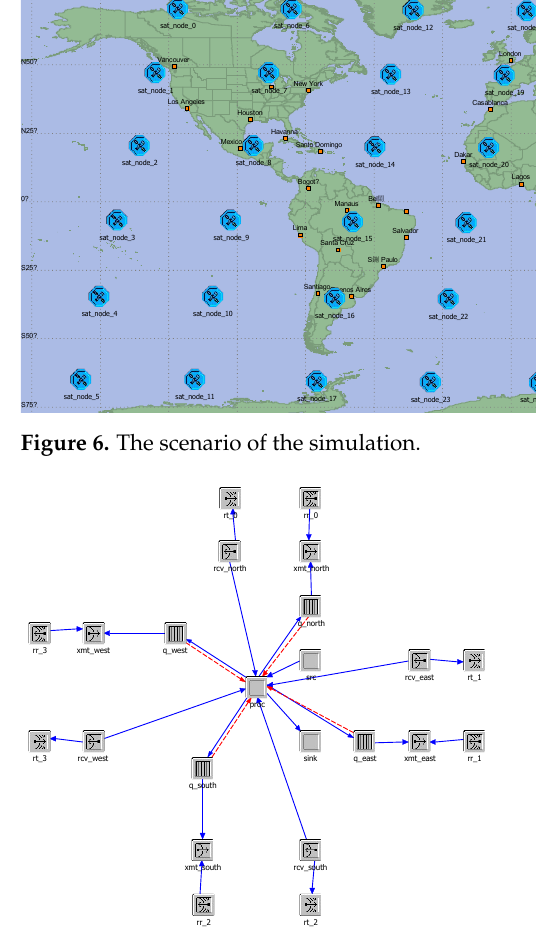
Figure 7. Satellite